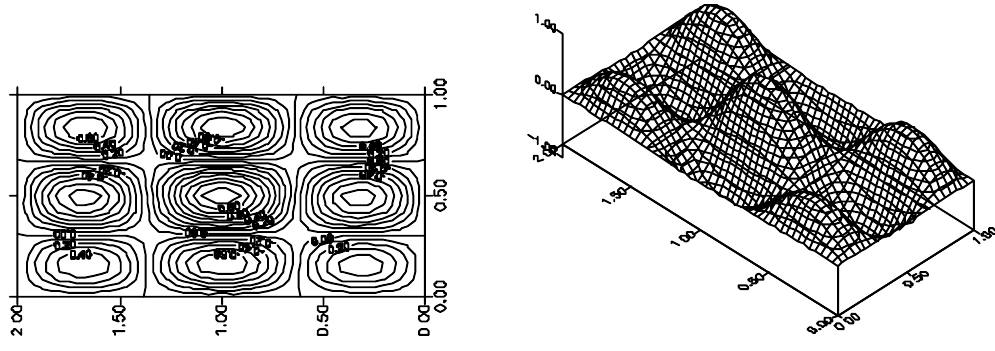
Fig. 6. (a). Mode shape of U3(3,1) for an isotropic shell panel with b/a = 2, R/a = 10, a/h = 10. (b). Mode shape of U3(3,3) for an isotropic shell panel with b/a = 2, R/a = 10, a/h =